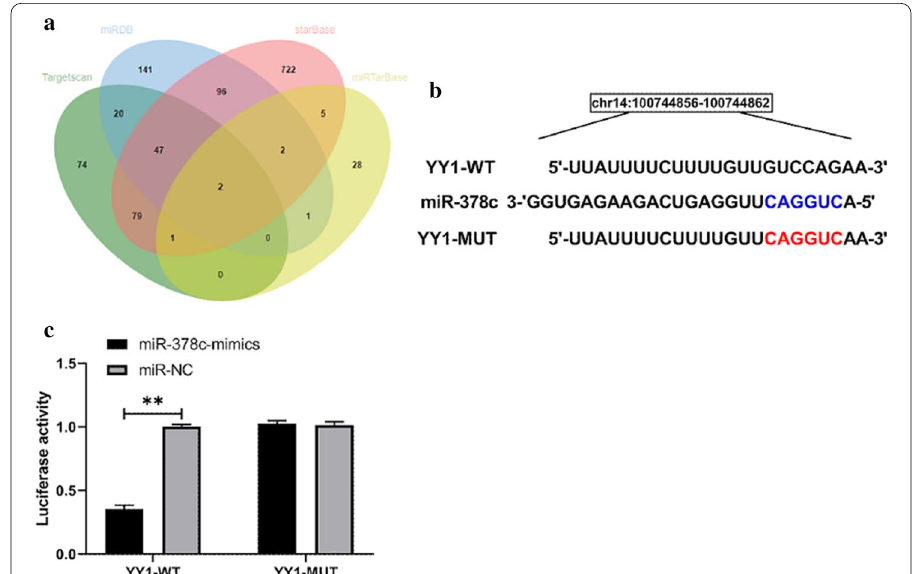
Fig. 2 Prediction and identification of miR-378c target gene. a TargetScan, miRDB, starBase, miRTarBase onlinemiR prediction websites were used to predict miR-378c target genes. b Binding and mutation sites ofmiR-378c and YY1. c Dual-Luciferase Reporter assay revealed that miR-378c had a targeting relationship with ROCK1.